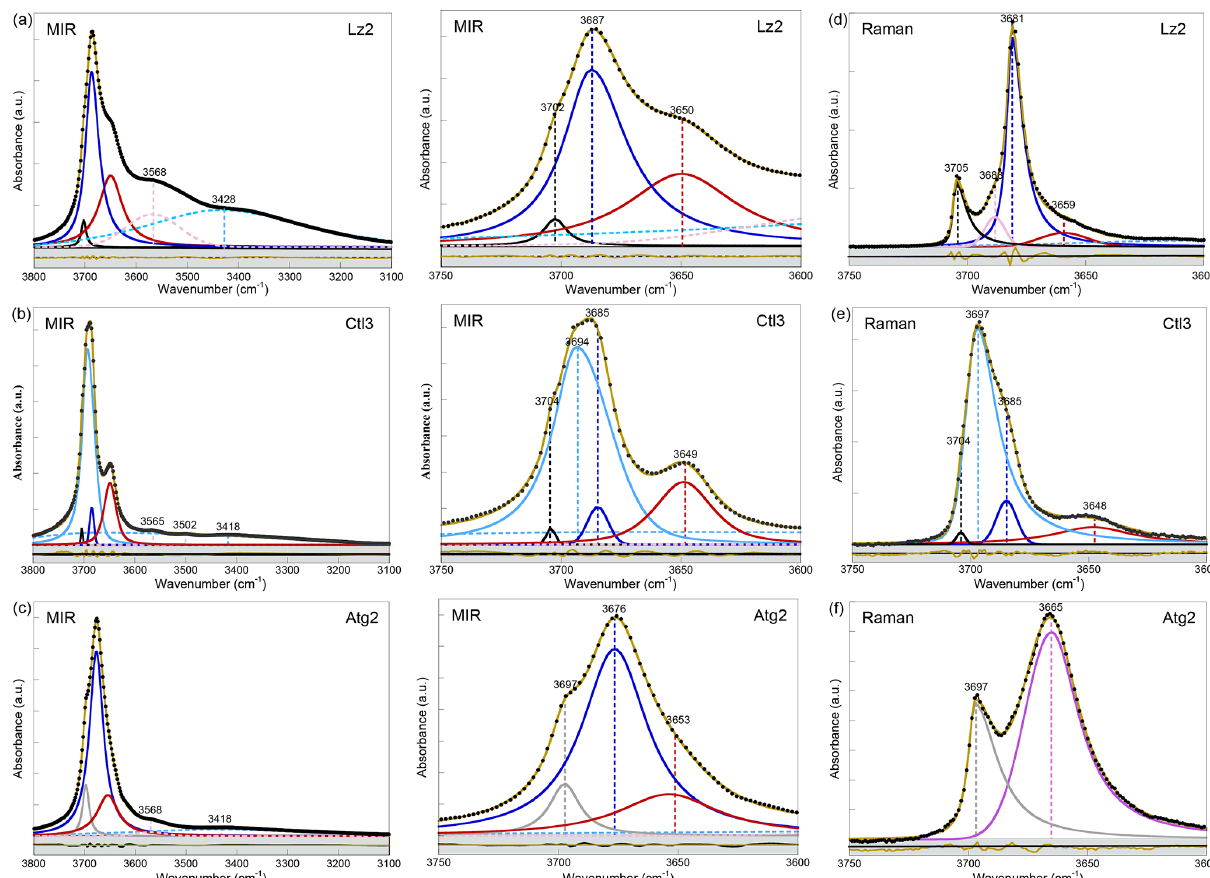
Figure 2. Left: MIR spectra of samples (a) Lz2, (b) Ctl3, and (c) Atg2 in the 3800–3100cm − 1 range (OH and H 2 O vibrations). Centre: enlarged view of the MIR OH stretching bands between 3750 and 3600cm − 1 (see Appendix A, Fig. A2 for the complete set of samples). Right: Raman spectra of samples (d) Lz2, (e) Ctl3, and (f) Atg2 in the 3750–3600cm − 1 range (OH stretching bands). The spectra have been decomposed into individual components using asymmetric Lorentzian–Gaussian functions. Black dots: experimental data. Solid brown line: best fit (residues in bottom grey box). Plain black and grey curves: inner OH stretching modes. Plain blue and red (or purple) curves: interlayer OH stretching modes. Dashed pink and light blue curves: H 2 O vibration